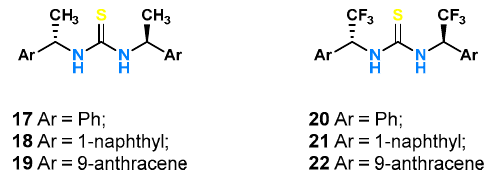
Figure 7. Receptors 13 – 16 based on BINOL decorated with tryptophane.